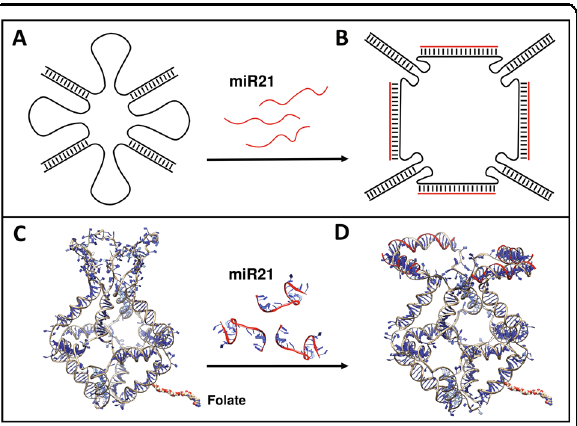
Fig. 1 Schematic and atomistic representation of Fol-miR21-NC. A Schematic top view of the four sequestering units in the unbound state. B Schematic top view highlighting the bound state of Fol-NC upon interaction with miR-21 molecules. C, D Three-dimensional representation of the two states, showing the conformational change occurring in the Fol-miR21-NC after binding to